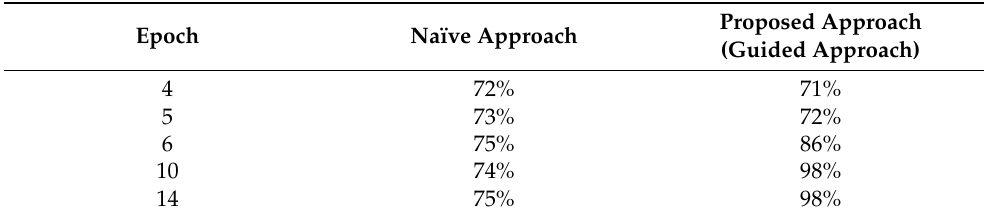
Table 1. Comparisons of Naïve approach and guided approach.